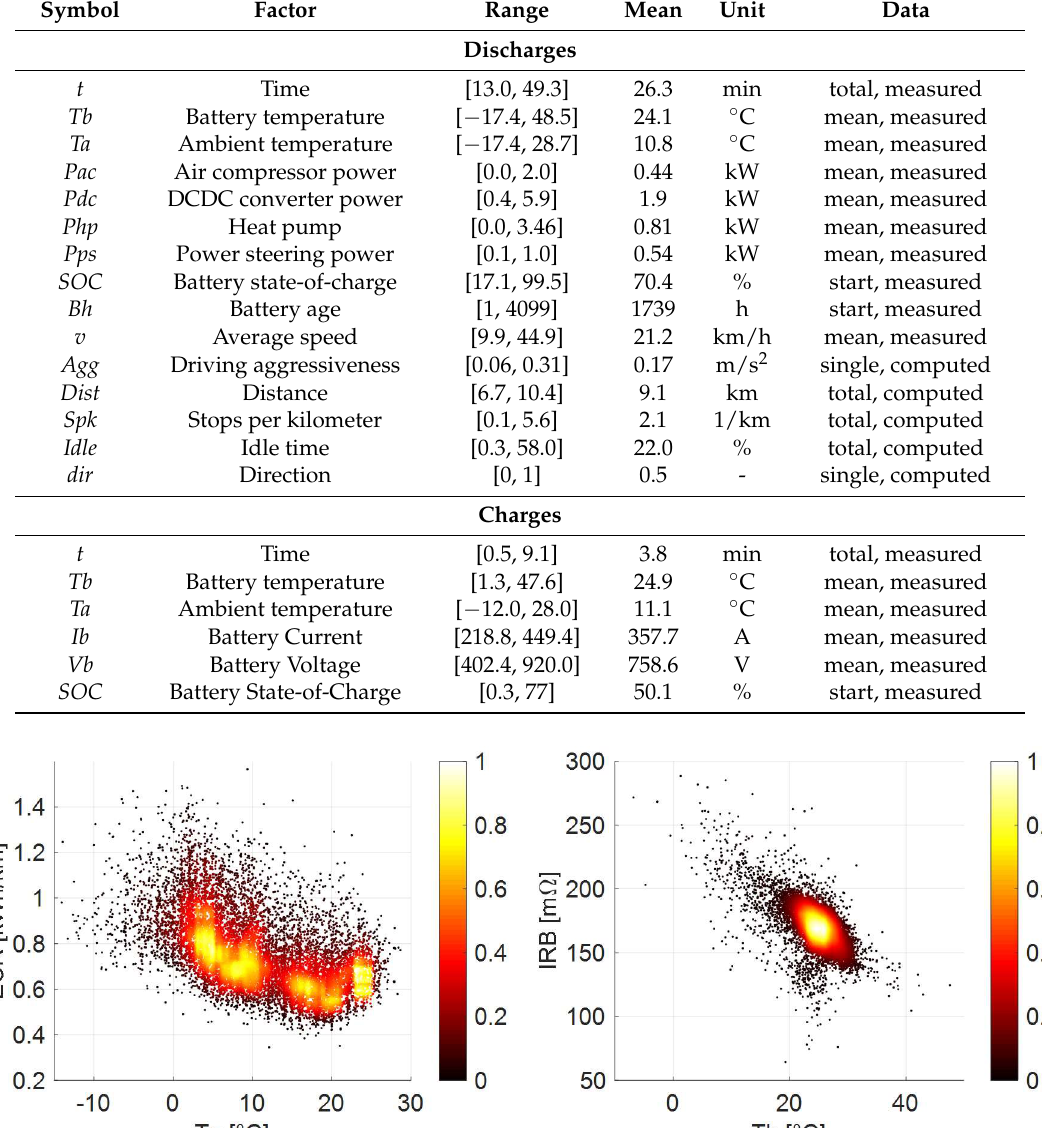
Figure 5. On the left, the parabolic relation between ambient temperature and energy consumption rate (ECR). On the right, the linear relation between battery temperature and internal resistance of the battery (IRB).